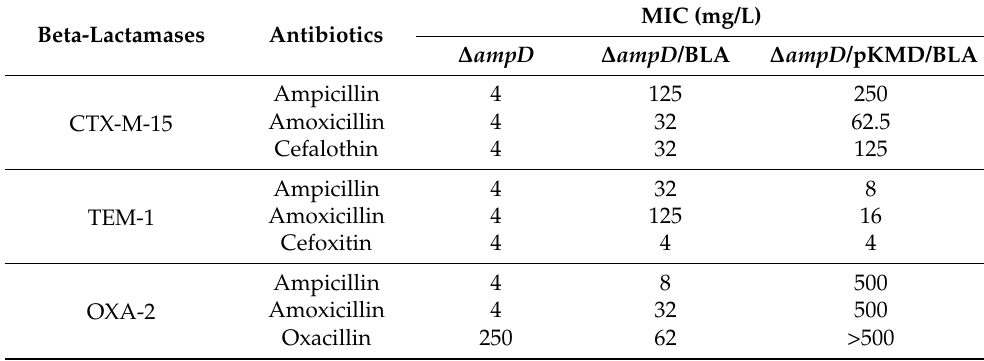
Table 4. Antibiotic sensitivity of E. coli expressing serine beta-lactamases affected by ampD